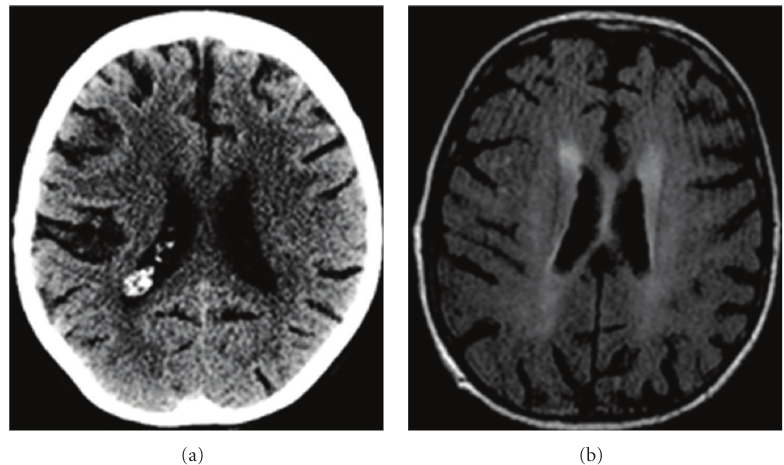
Figure 3: Associated findings. Unenhanced CT and MR FLAIR images of the brain demonstrate non-specific white matter related changes that can be associated with peripheral hemorrhages in cerebral